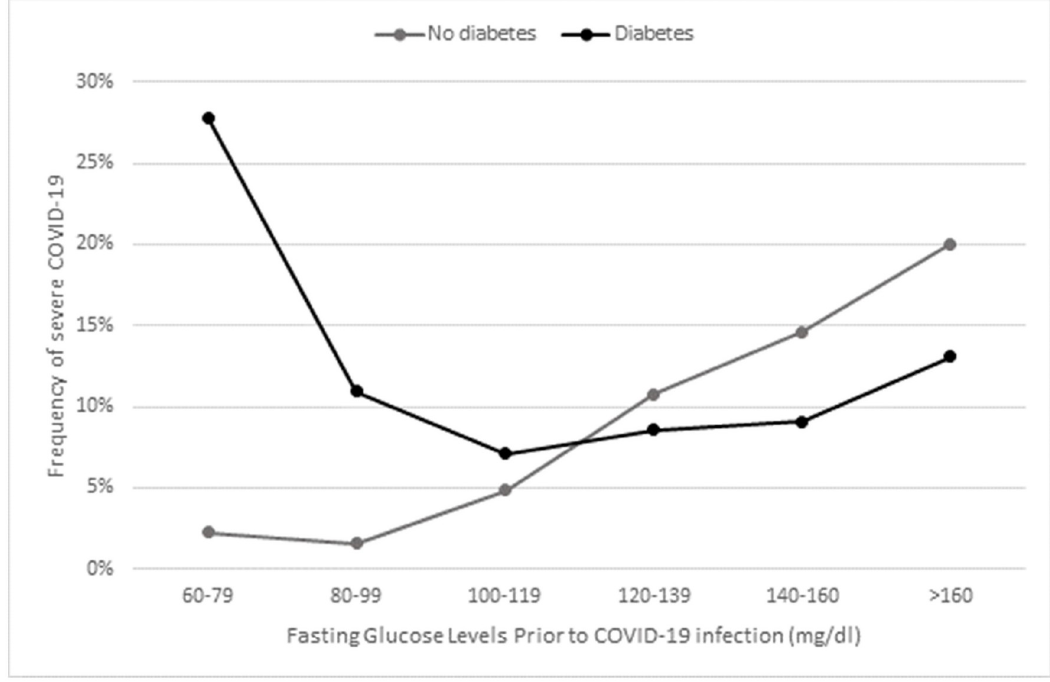
Fig 2. Frequency of severe COVID-19 (death/ICU/ hospitalization � 10 days) by pre-infection fasting blood glucose, among patients with (in black) and without (in grey) a diagnosis of diabetes.